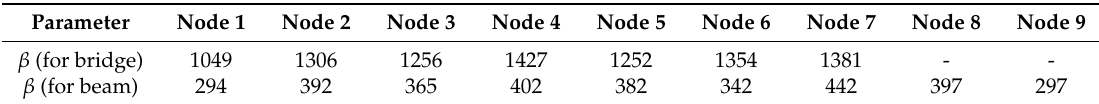
Table 4. β calculated for all signals under moving load in the laboratory for no-damage condition considering the speed as v = 0.3 m/s.